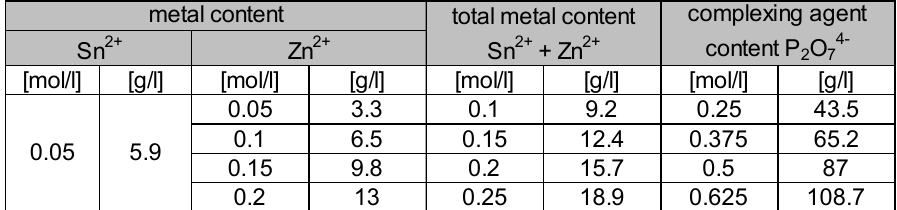
Table 1 – Variations of the metal and complexing agent concentration in the baths Таблица 1 – Варианты концентрации металлов и сплавов для покрытия